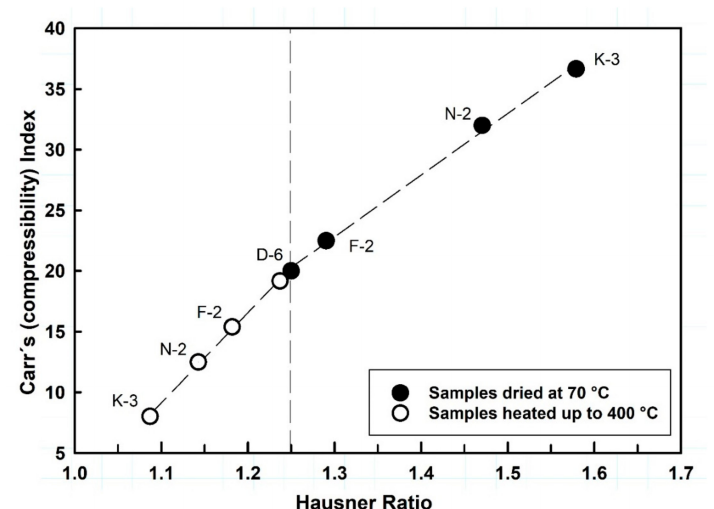
Figure 9. The relationship between the flow parameters HR versus CI of the studied kaolin powders, showing significant flowability improvements with the thermal e ff ect.